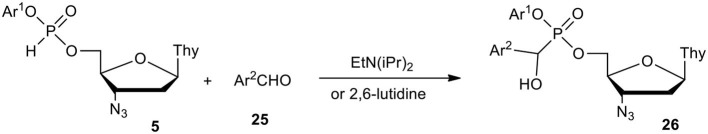
Scheme for the synthesis of aryl nucleoside α-aryl-α-hydroxyphosphonates of type 26 on the example of AZT derivatives.